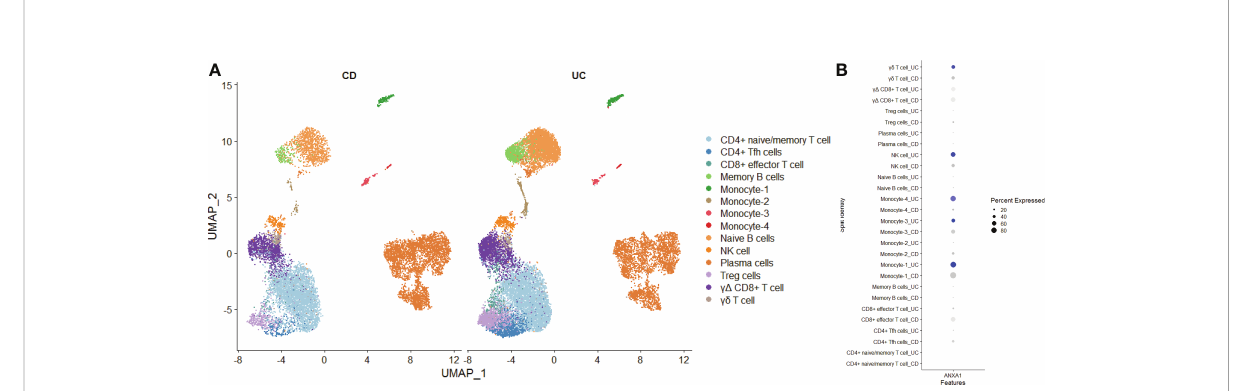
FIGURE 11 Exploring the Expression of MMP-Associated Genes by Single-cell Sequencing (A) Intestinal mucosa samples from 14 IBD patients (7 UC and 7 CD) were integrated through the Harmony method and are displayed in a UMAP reduction diagram. (B) ANXA1 expression in different cell